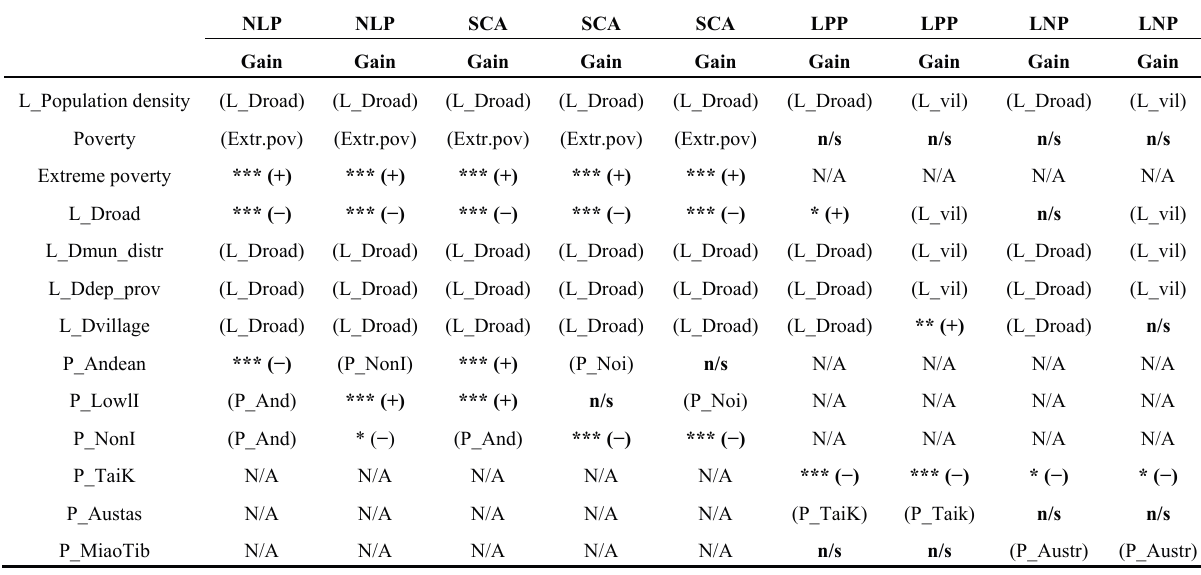
Table 6. Significance of explanatory variables for relative forest gain in the multivariate stepwise regression